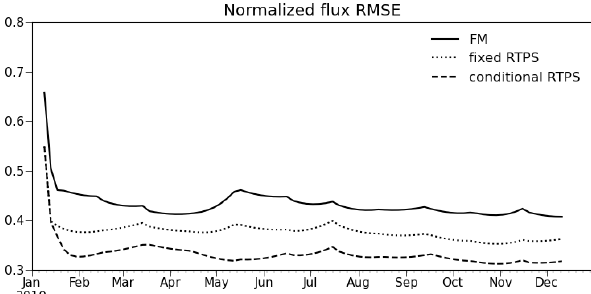
Figure 2. Time series of normalized RMSE of surface CH 4 flux analysis, for 1 year of data assimilation using FM, fixed RTPS, and conditional RTPS inflation methods over the global landmass re-